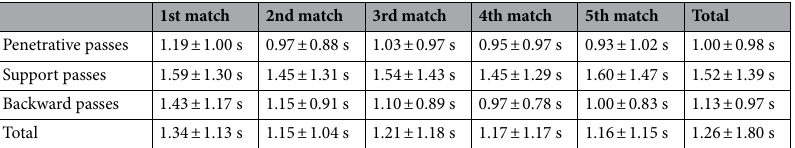
periods of a match. While the size of the time window and the update rate depend on the specific necessities of each team, a 10-min sliding window was chosen for illustrative purposes. For instance, for the first half of the 4th match, exemplar heatmaps of penetrative passing opportunities with time windows of 10 min were created. Three of these heatmaps are presented to show the dynamical evolution of these landscapes. On these heatmaps the color scale was adjusted to have dark red in the areas that were under potential passes for 30 s. Additionally to go beyond a visual inspection, the heatmaps of the five matches for each type of pass were compared using the Earth Mover’s Distance (EMD; please see 26 for further explanation of this method). This method provides a measure of similarity between two images 27 , with lower values meaning high similarity and vice versa. As an EMD output we created a colored matrix where the coldest colors (i.e., blue, green) display a high similarity between heatmaps, whereas the warmest colors (i.e., yellow, orange, red) display a low similarity